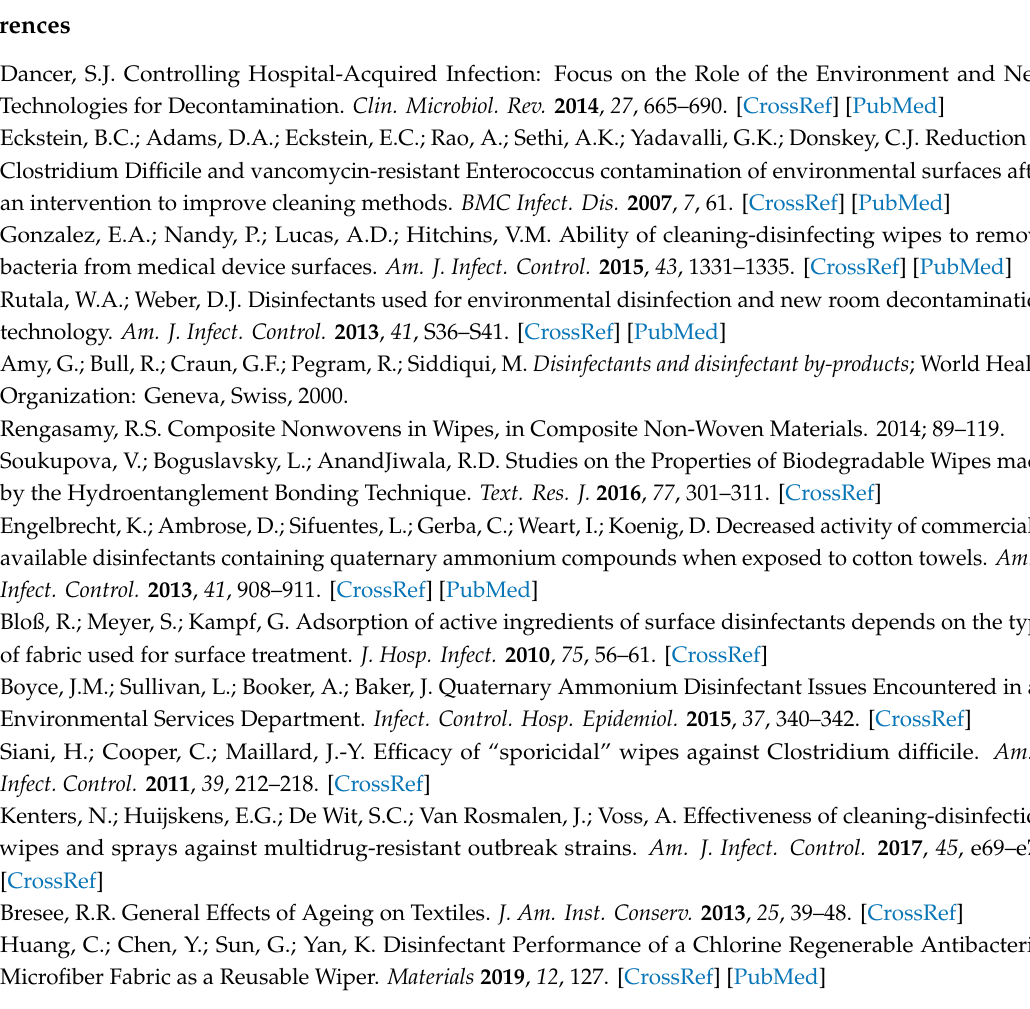
ANOVA result of E.